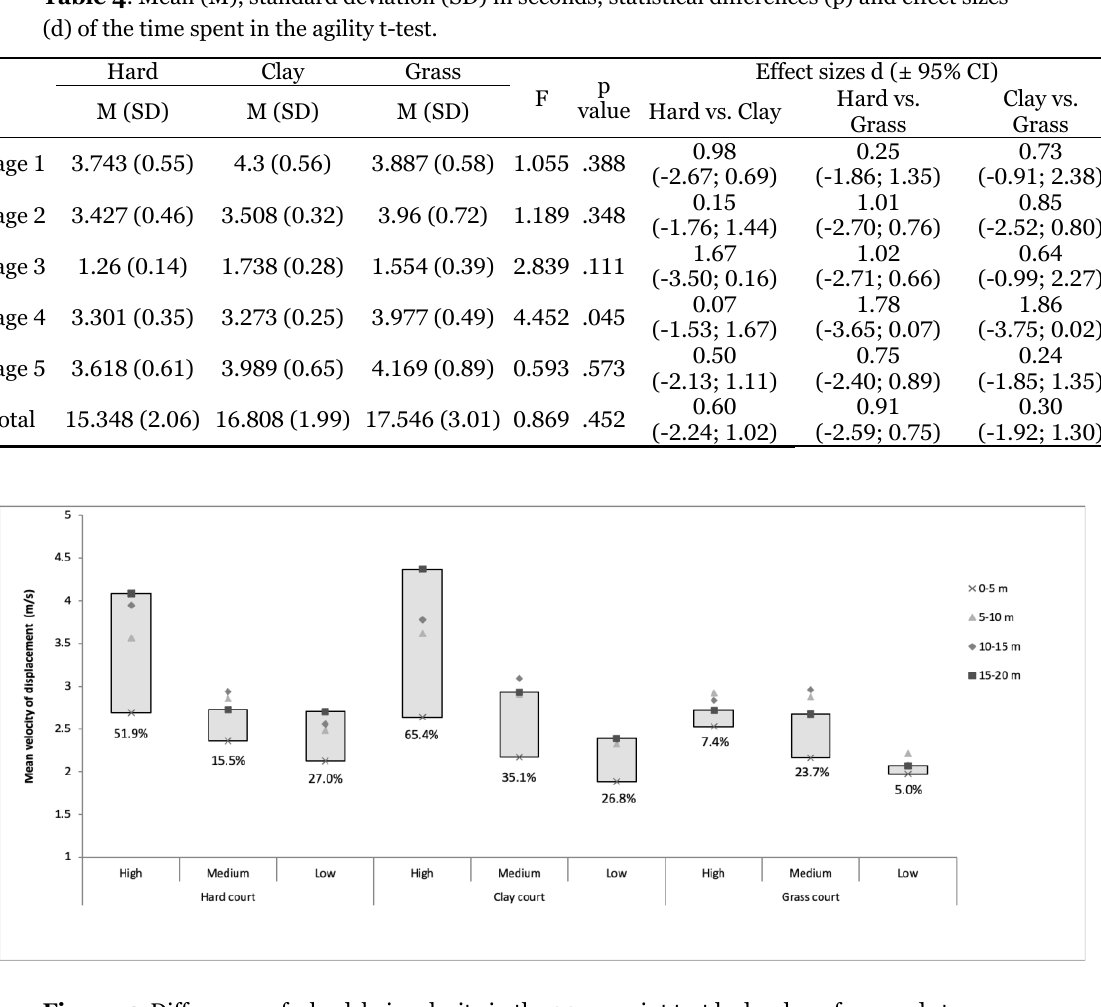
Figure 4 . Differences of wheelchair velocity in the 20 m sprint test by level, surfaces and